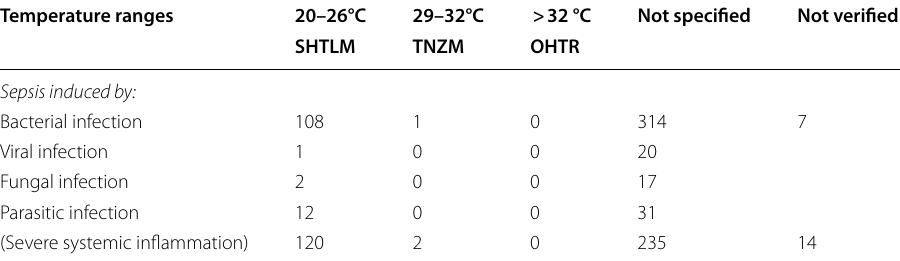
Results of a literature research derived from a PubMed search with restriction to time of publication (2019–2022) but not language using EndNote X9 and keywords: sepsis and mouse and in vivo. ( SHTLM standard housing temperatures for laboratory mice, TNZM thermoneutral zone for mice, OHTR overheating temperature